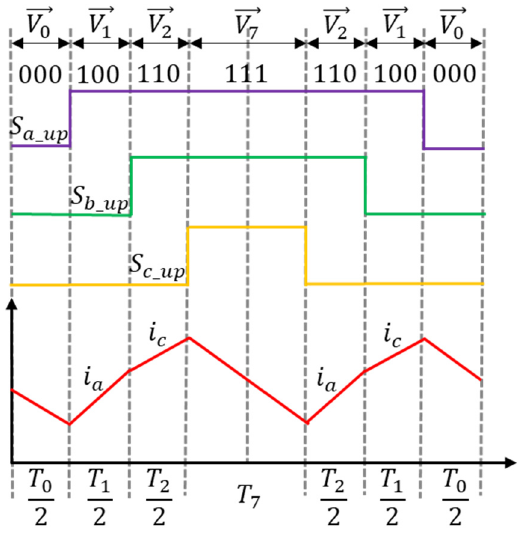
Figure 4. Voltage reference vector in different regions and the output current. Current flow paths under different vectors are shown in Figures 5 and 6. S i means the switching state of three phase power electronic device, when S i = 0, the low switch of i phase is turn on while the high switch is turn out, on the contrary, when S i = 1, the high switch of i phase is turn on while the low switch is turn out.